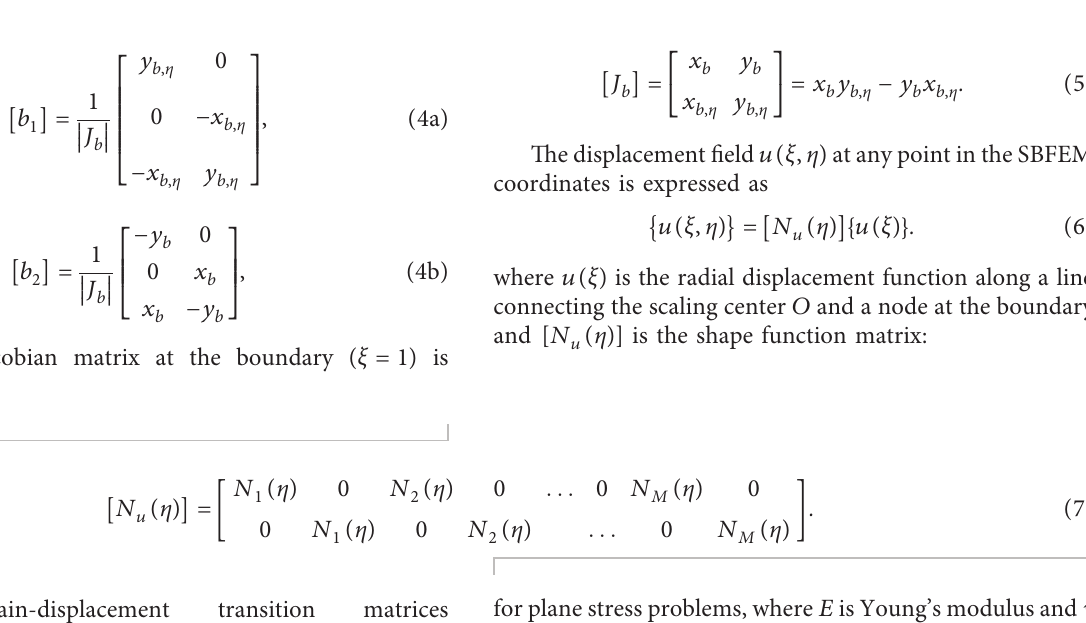
Figure 1: Scaled boundary finite element coordinate system on a generic